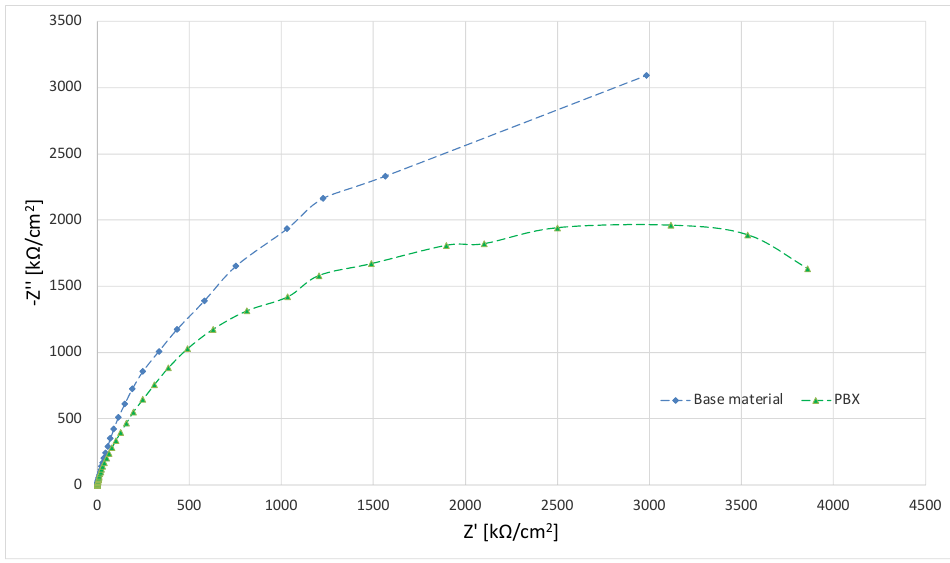
Figure 13. Nyquist summary plot for all tested samples .